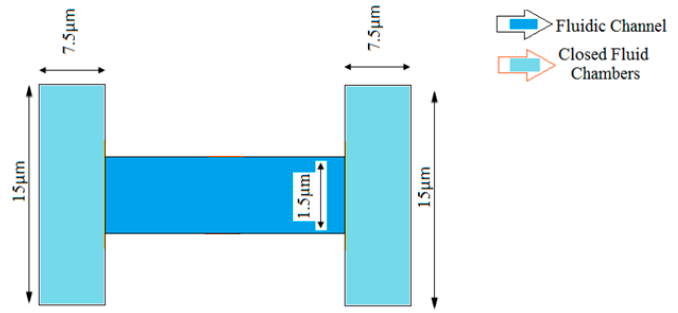
Figure 2. Structure of microfluidic channel.